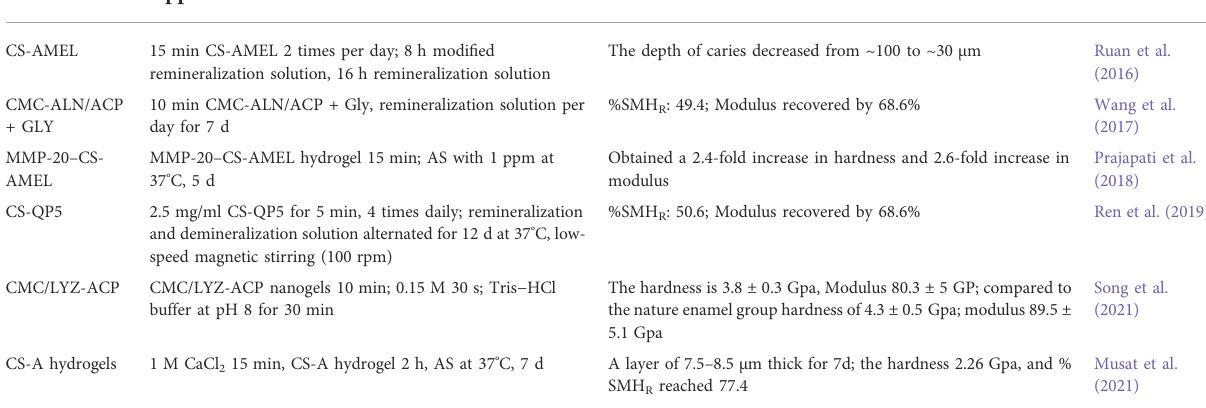
TABLE 3 Summary of chitosan basing remineralization systems.